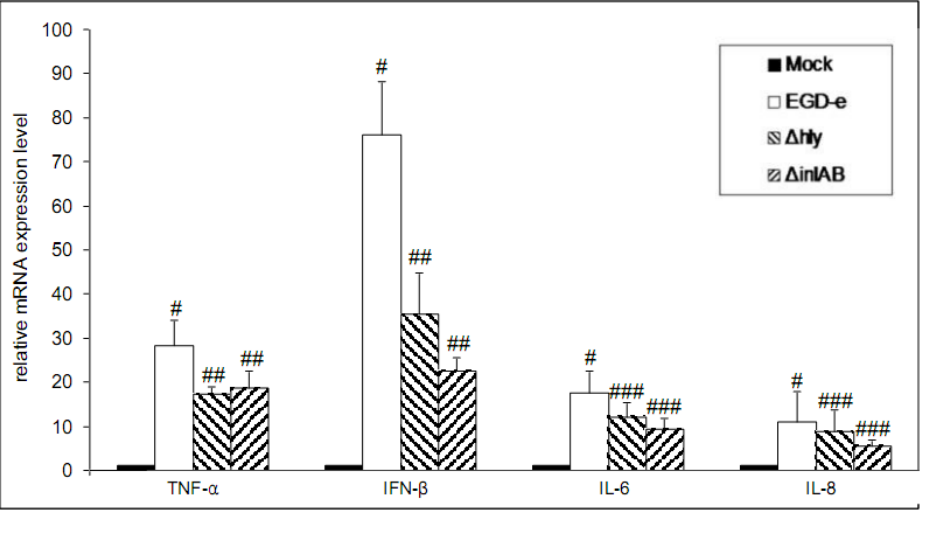
Figure 3. Conformation of immune response target genes by real time PCR analysis. Real time PCR analysis of immune response target genes was performed from uninfected Caco-2 cells compared to infected Caco-2 cells at 1 h post infection for L. monocytogenes EGD-e wild-type, Δ hly and Δ inl AB. Error bars indicate standard deviations. # significant difference compared to control ( p -value < 0.05). ## significant difference compared with wild-type infection ( p -value < 0.05), ### no significant difference compared with wild-type infection ( p -value > 0.05).